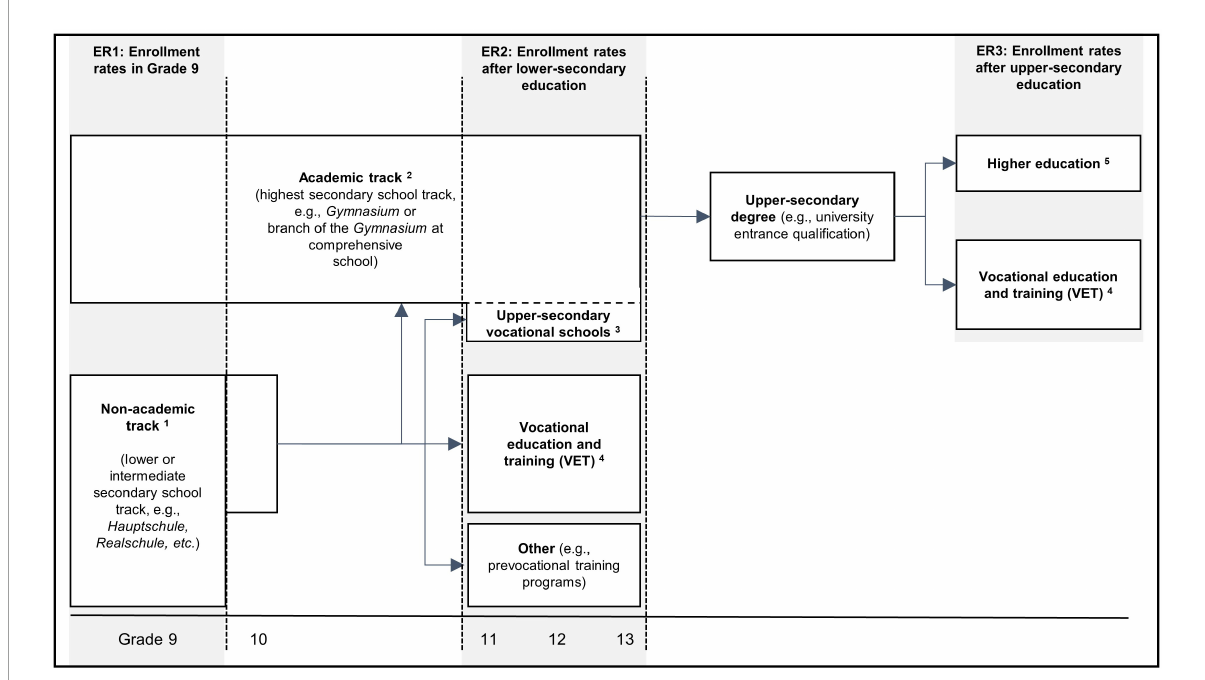
FIGURE1 Analysis plan. 1 School tracks (e.g., Hauptschule , Realschule , and other kinds of combined schools) not leading to an upper-secondary degree. 2 School tracks (e.g., Gymnasium or a branch of a Gymnasium at a comprehensive school) leading to an upper-secondary degree (e.g.,